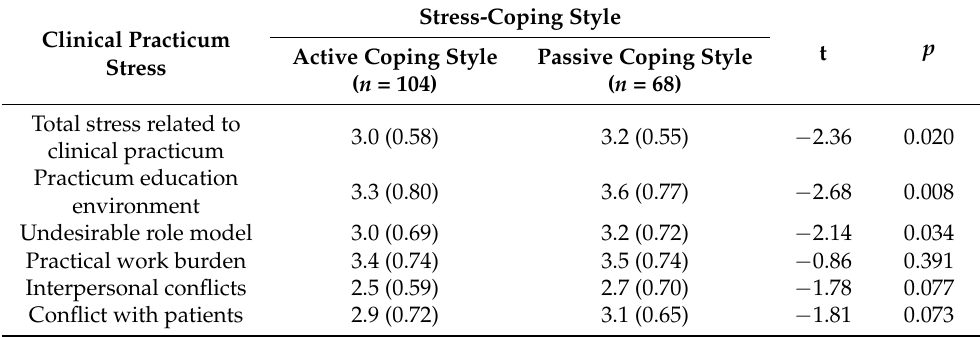
Table 4. Stress related to clinical practicum according to stress-coping styles ( n =